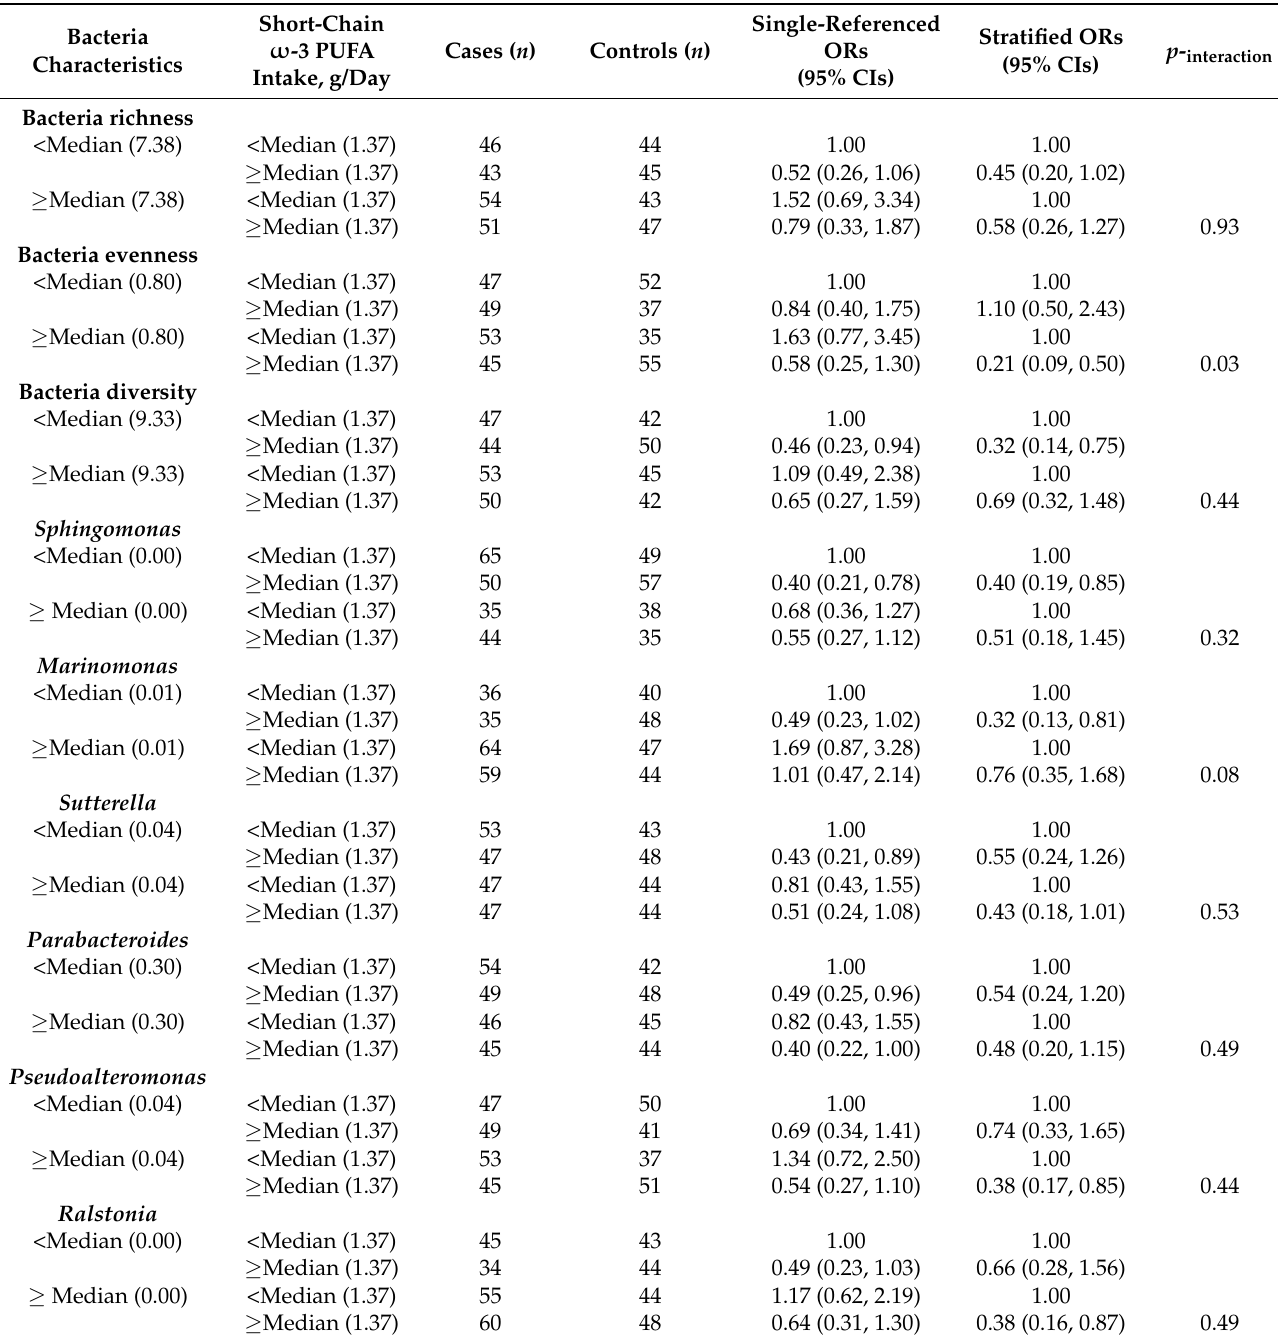
Table 4. Adjusted multi-variable a interaction analysis of short-chain ω -3 polyunsaturated fatty